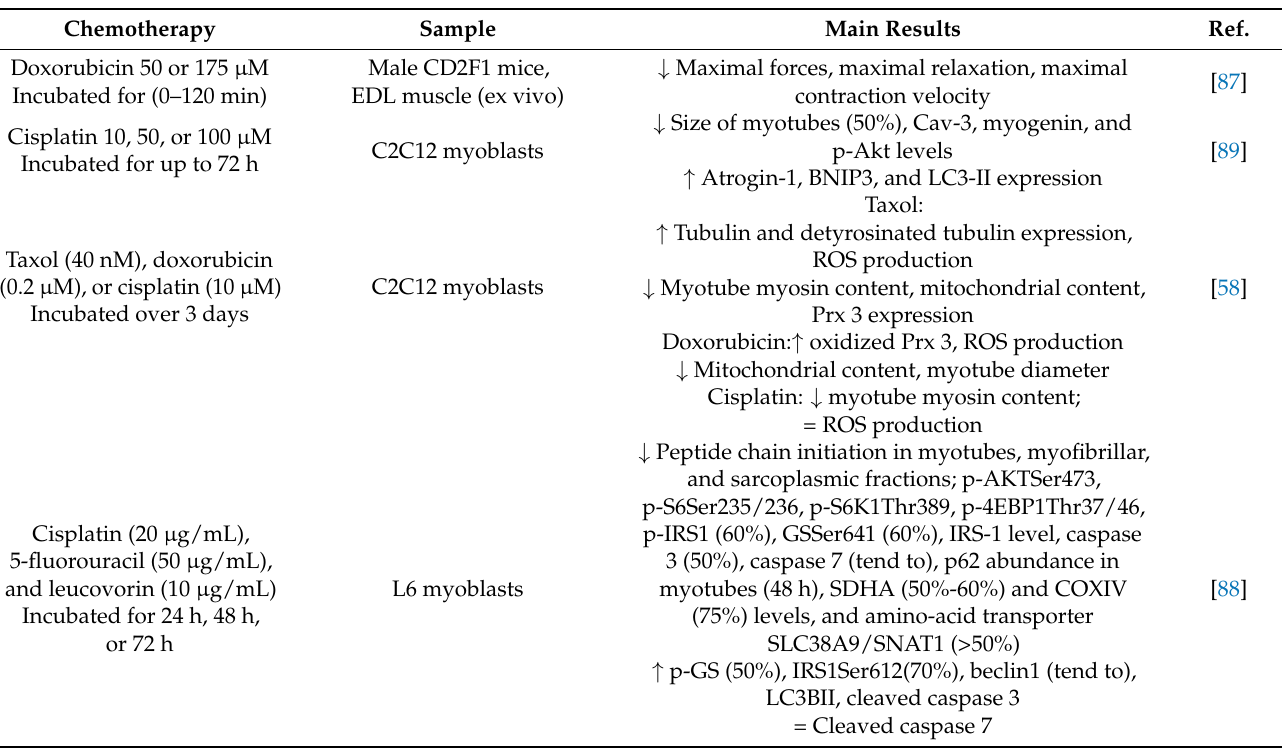
Table A1. In vitro and ex vivo studies about the effects of